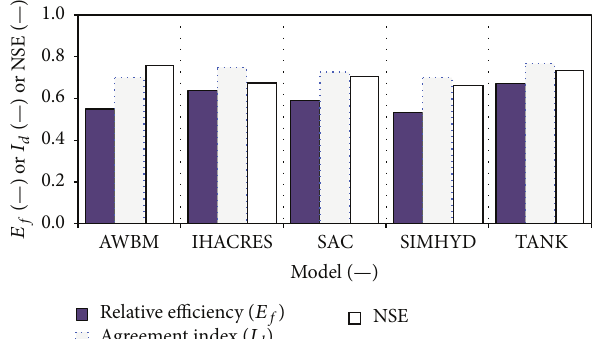
Figure 7: Performance of the models in terms of the forecast accuracy and